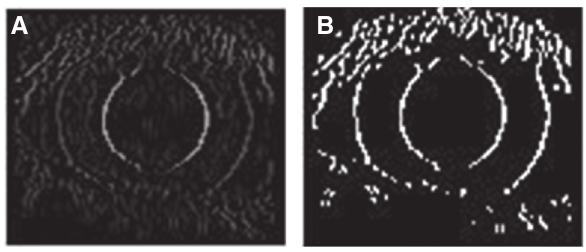
Figure 9. Hysteresis Thresholding Result.